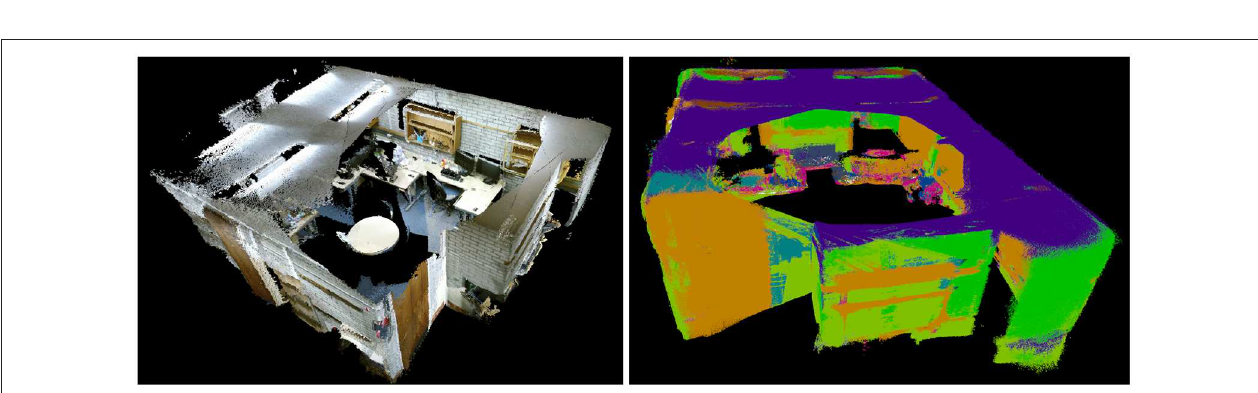
FIGURE 7 | Material segmentation and reconstruction in an industrial scenario. (Left) Local 3D map. (Right) Local 3D semantic map.